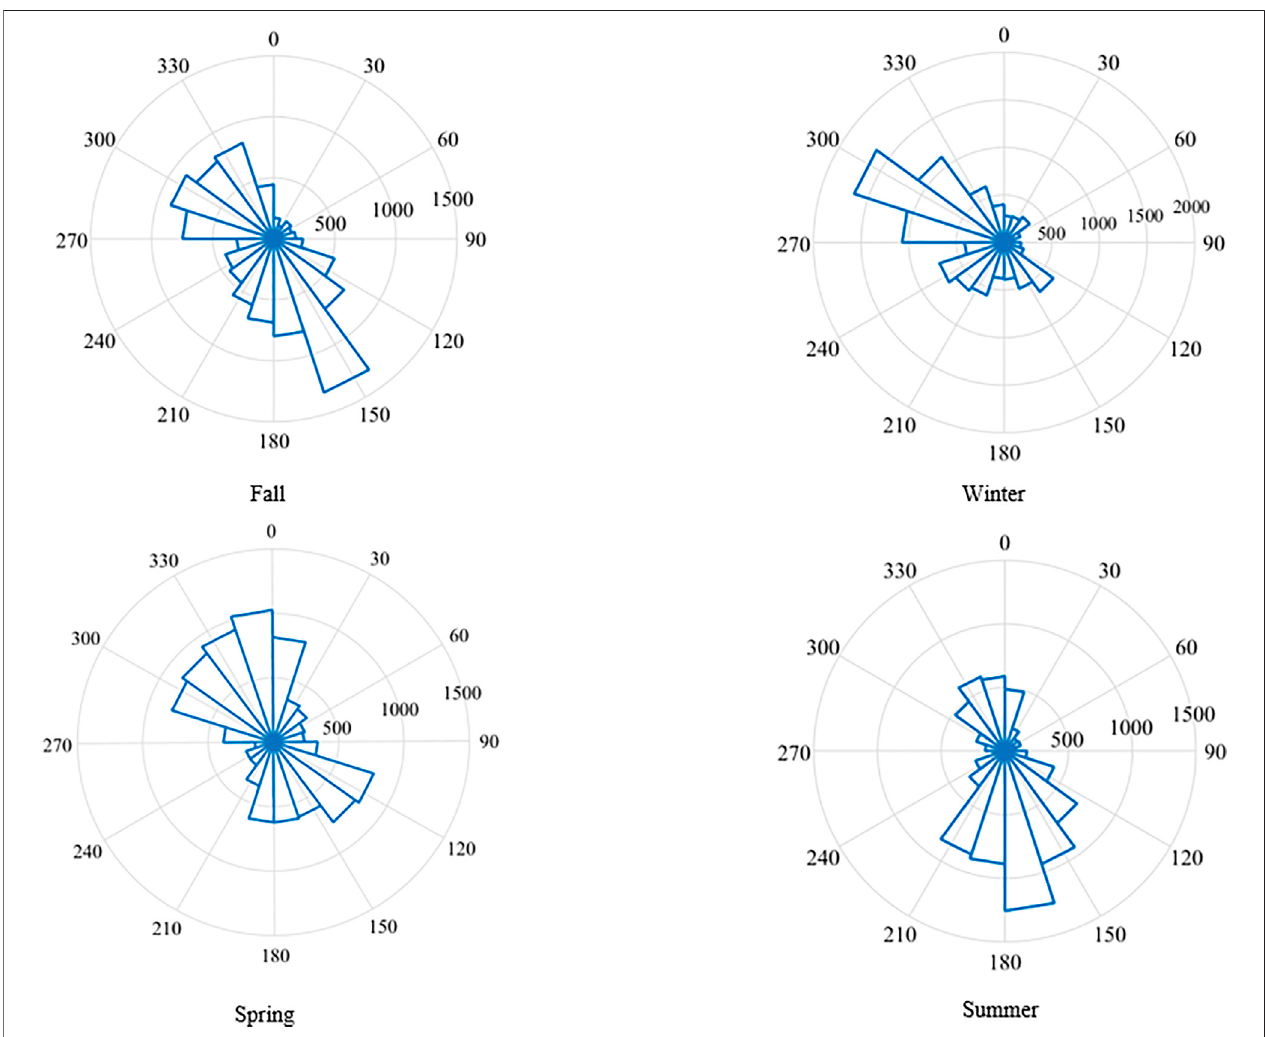
FIGURE 2 | Wind rose diagrams for four seasons.